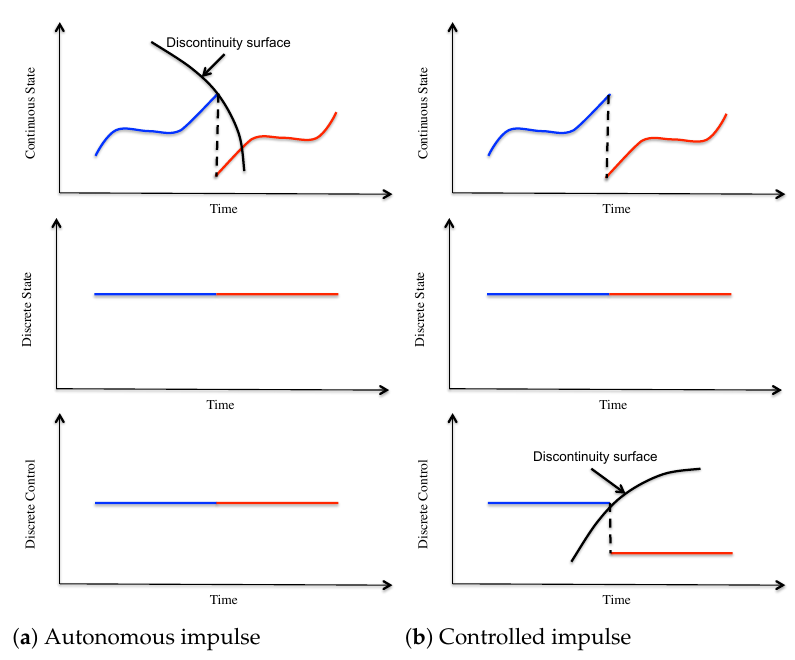
Figure 2. Illustration of impulsive discrete